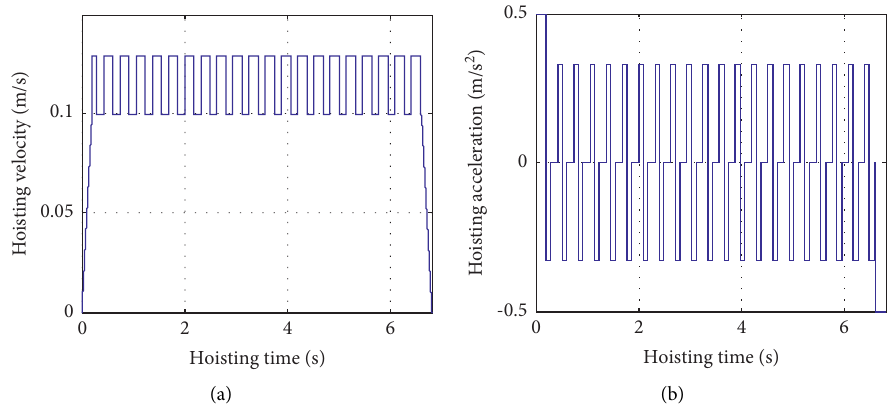
Figure 11: Hoisting profile of the test rig. (a) Hoisting velocity of the test rig. (b) Hoisting acceleration of the test rig.